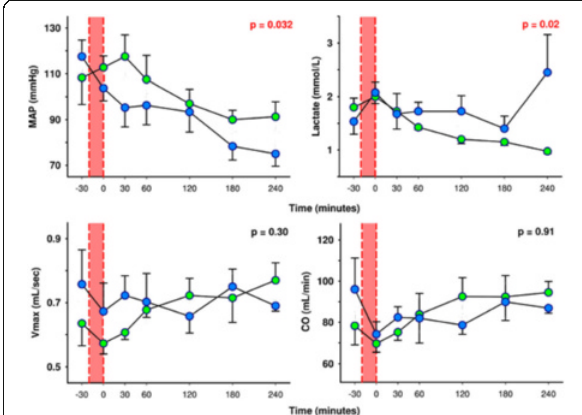
Table 69. Mortality rate in group 1 is 12.5 % compare to 2.2 % in group 2 (p = .07), shown in Table 69. Conclusions Usage smartphone to transmit ECG in the ED to inter- ventional cardiologists can facilitate communication and reduce the time of CCL activation and balloon inflation.